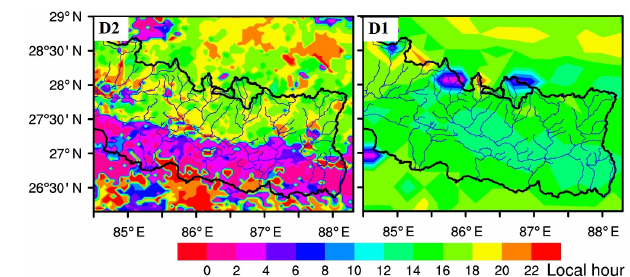
Figure 17. Spatial pattern of peak precipitation hours (local) during the monsoon season in a large area of D2 and